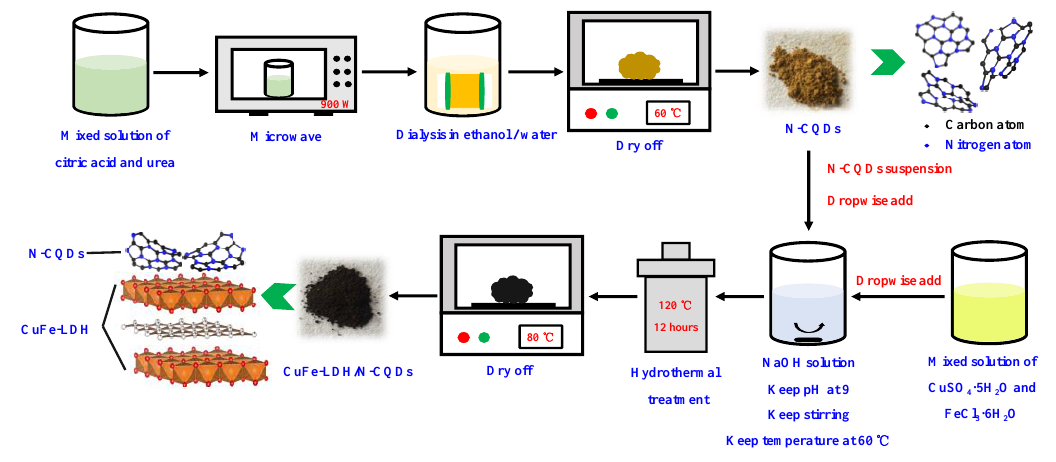
Figure 12. The preparation process of CuFe-LDH/N-CQDs.